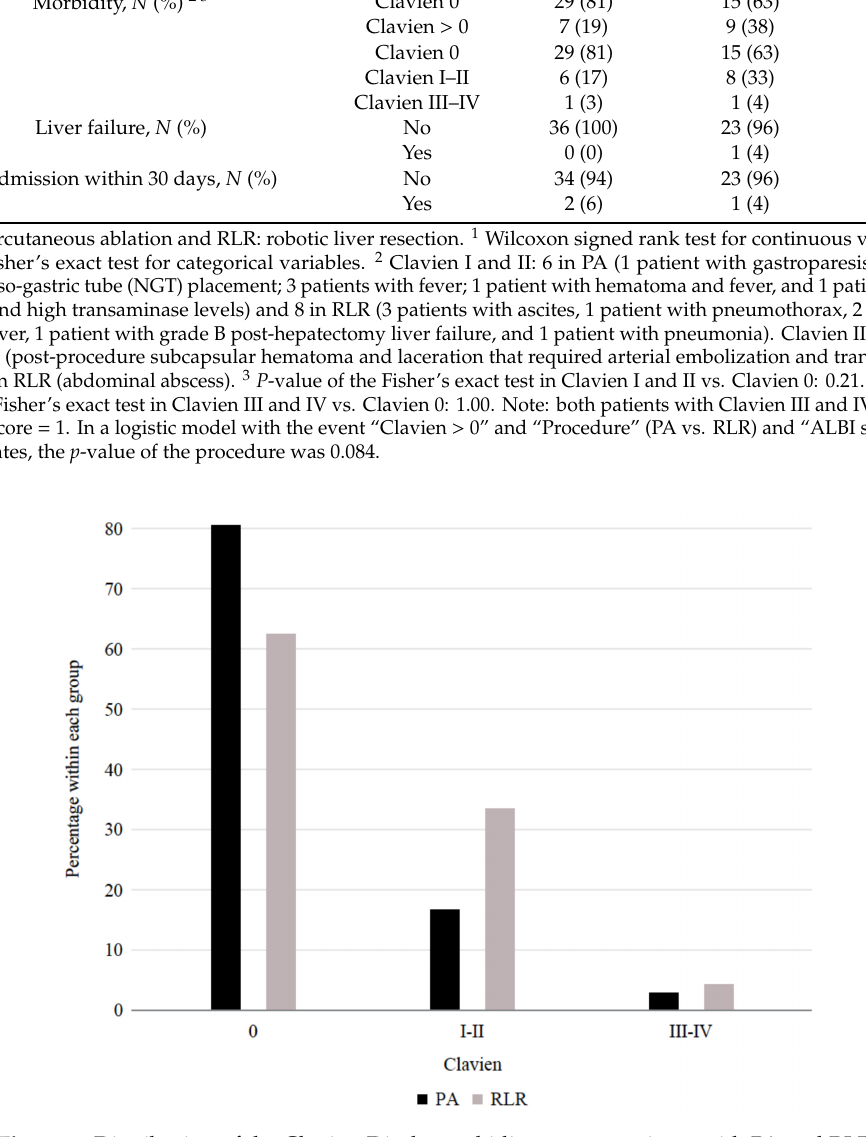
Figure 2. Distribution of the Clavien-Dindo morbidity among patients with PA and